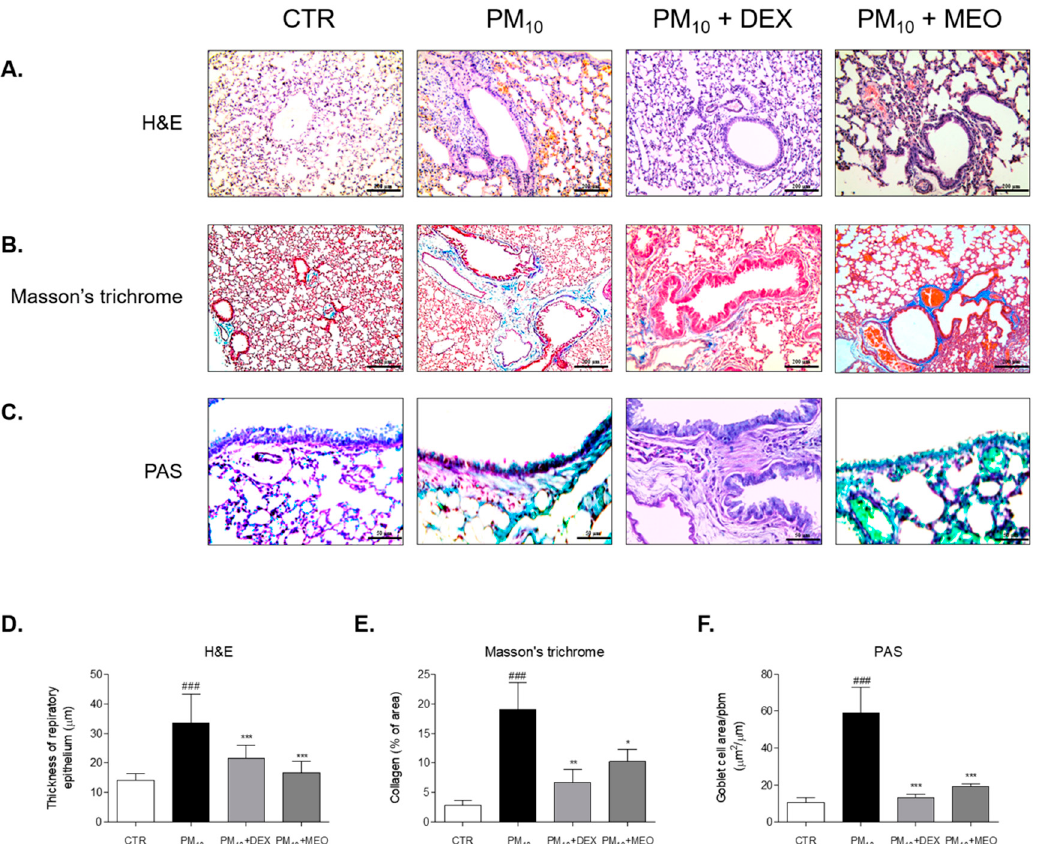
Figure 3. Histological changes of lung tissues stained by Hematoxylin and Eosin ( A ), Masson’s trichrome ( B ) and Periodic acid–Schiff (PAS) ( C ) in ovalbumin (OVA) and PM 10 -exposed mice. Thickness of respiratory epithelium ( D ), collagen deposition % of area ( E ) and goblet cell number per area ( F ) were shown as relative quantified values. The slides of each mice ( n = 7) were evaluated by randomly selecting 3 photographs and a total 21 images were quantified using Image J computerized densitometry system. Results are presented as mean ± standard error of the mean. ### p < 0.001 vs. CTR group; * p < 0.05, ** p < 0.01 and *** p < 0.001 vs. PM 10 group.